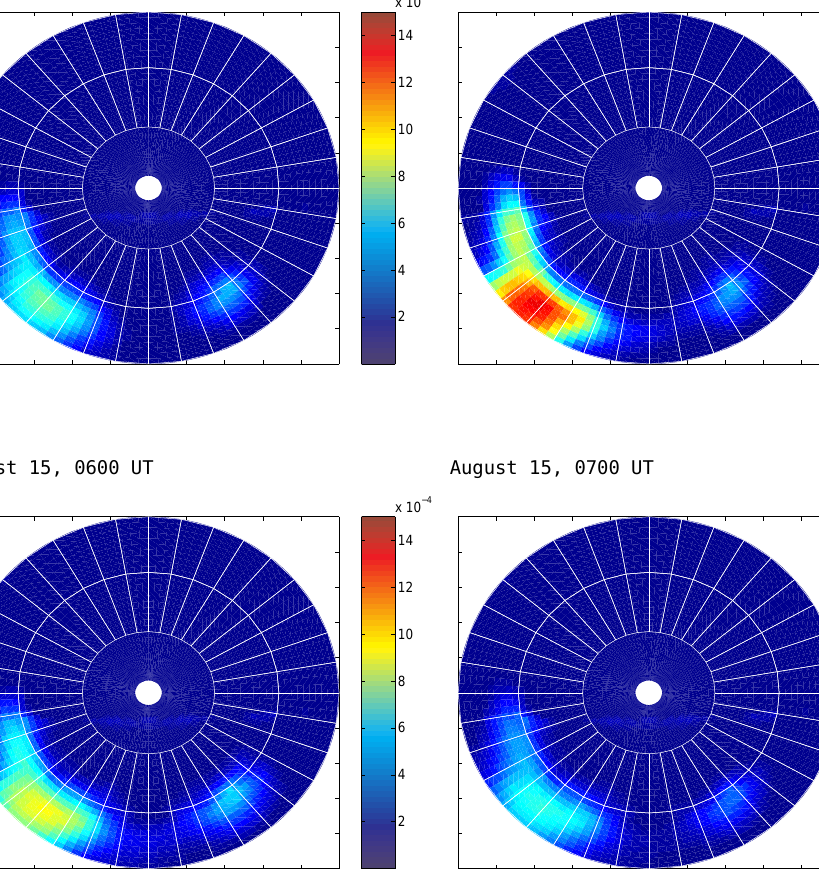
Fig. 8. Precipitation power color-coded in the simulation at six moments of time during the August 2001 substorm, units Wm − 2 .